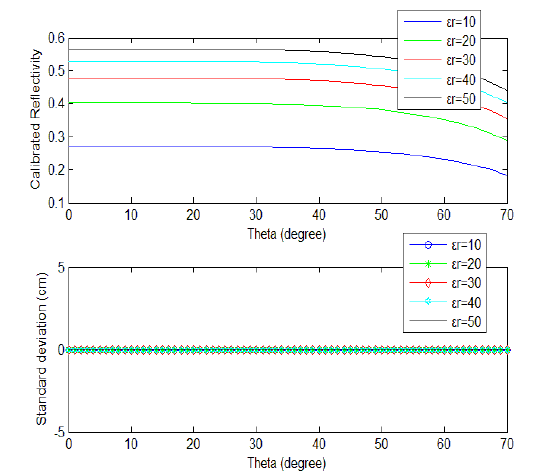
Fig. 1. The estimation of soil surface roughness for a flat surface.